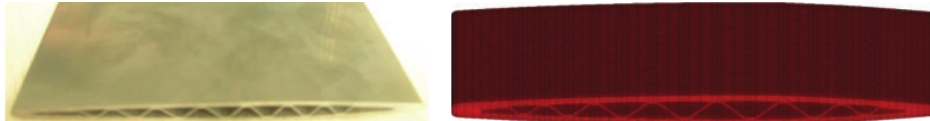
Figure 5: Finite element model of the hollow